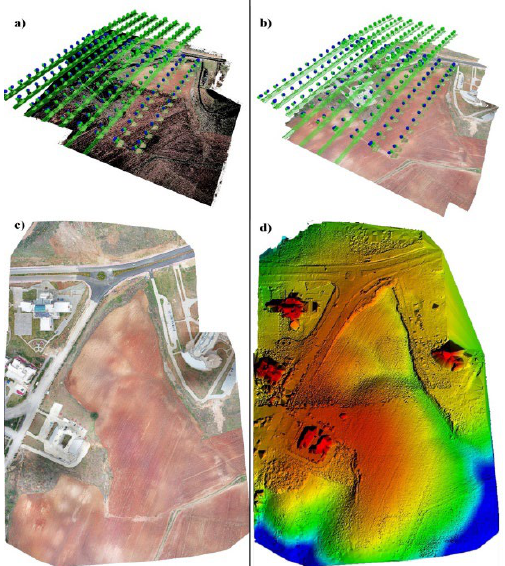
Figure 5 Generation of point cloud (a), surface modeling (b), orthophoto (c) and digital elevation model (d) images for merging photogrammetric images (Cukurova University Campus).